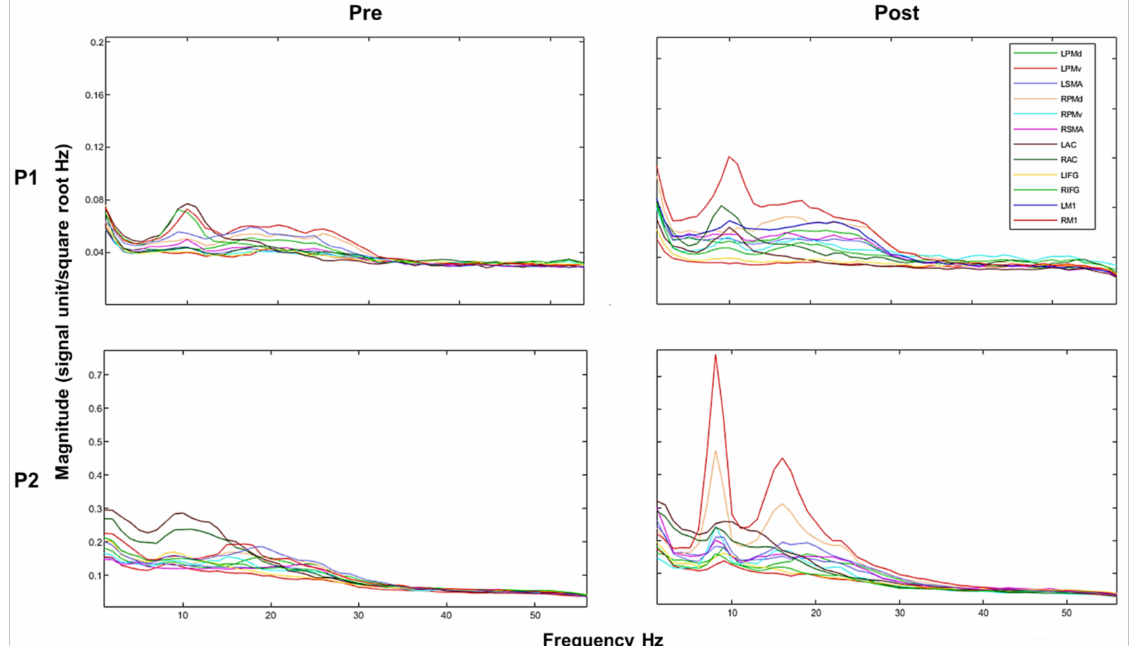
Figure 1. Power spectrum density plots for both participants, pre- and post-MST. (P1: Participant 1, P2: Participant 2, L: left, R: right, Pre: pre-training; Post: post-training, M1: primary motor cortex, AC: auditory cortex, SMA: supplementary motor area: PMv: premotor ventral area, PMd: premotor dorsal area, IFG: inferior frontal